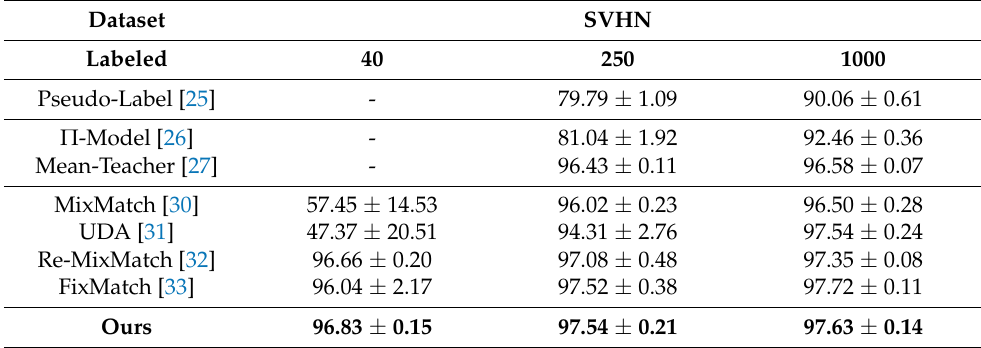
Table 2. Error rates for the test set on the SVHN